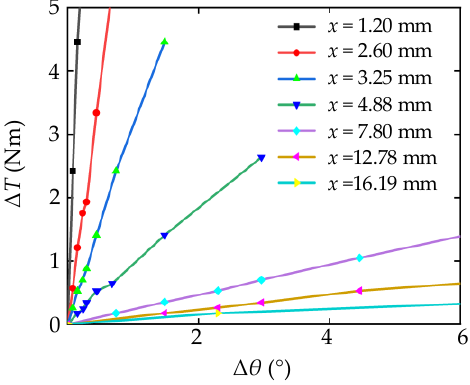
Figure 20. Curves of Δ T −Δ θ at different values of x .